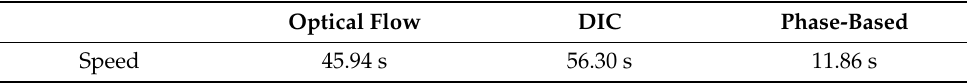
Table 3. Computational load of a single-story motion extraction using the three approaches.